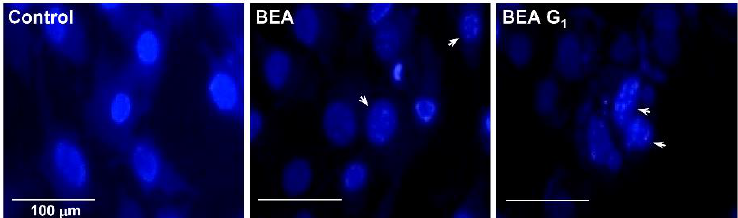
Figure 5. Effects of BEA and BEA G 1 on the nuclear apoptosis of A375SM melanoma cells. The cells were treated with BEA and BEA G 1 (5 μM) for 24 h. Changes in nuclear morphology were monitored by DAPI staining under a fluorescence microscope. Scale bar, 100 µm.